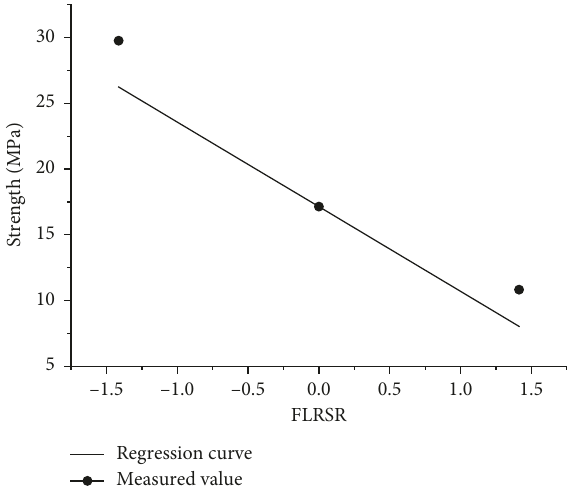
Figure 13: Influence of the substitution rate of rubber on 28d strength when the mixing amount of cellulose ether is 0.